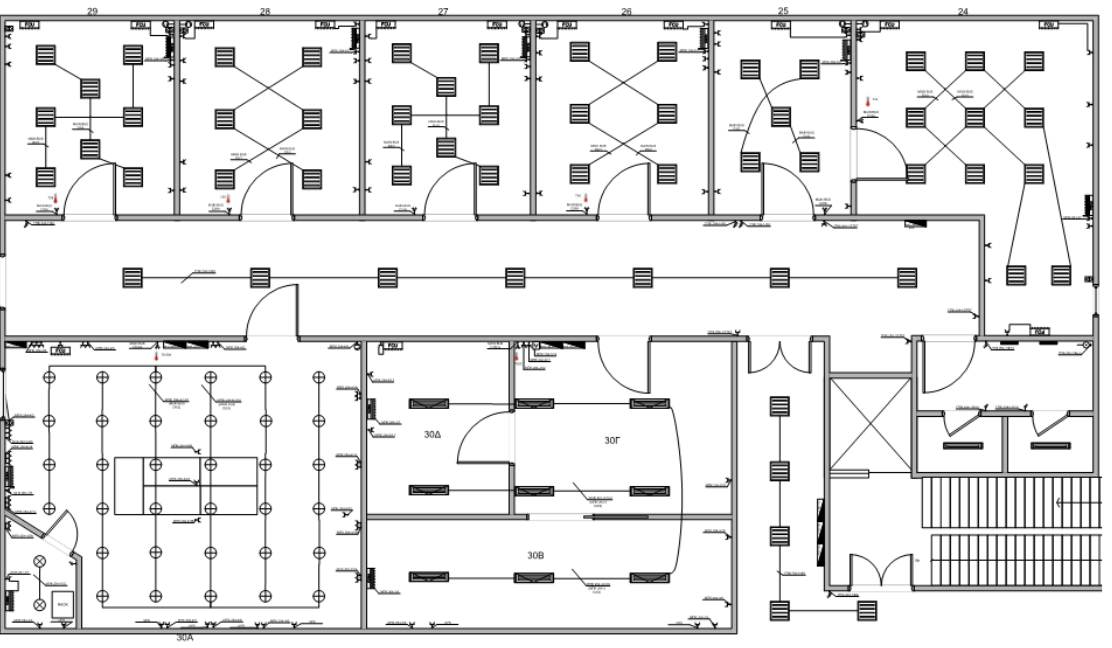
Figure 5. DSS Lab Plan, Floor 0.